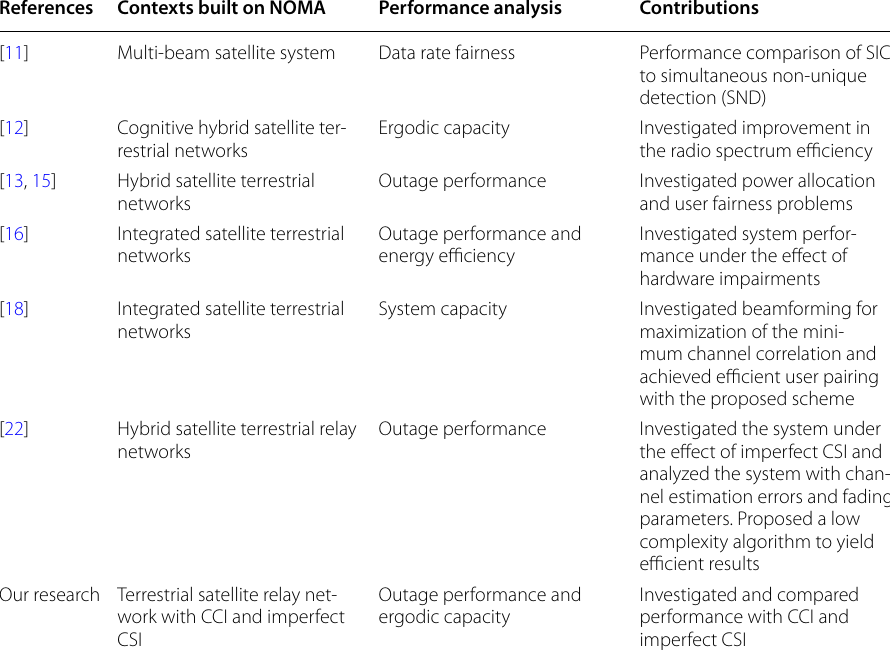
Table 1 Summary of related works References Contexts built on